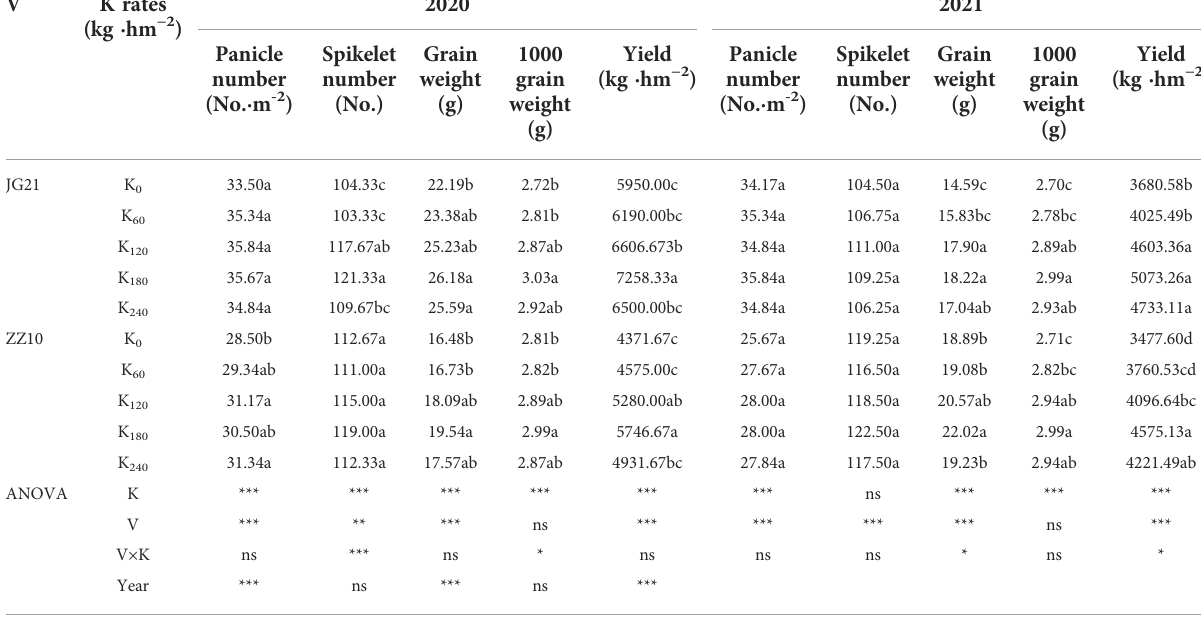
TABLE 4 Effects of potassium application rate on the yield components of foxtail millet. V K rates (kg ·hm − 2